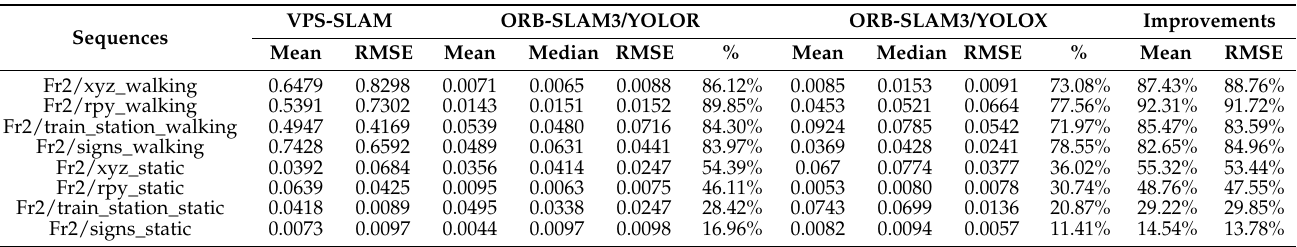
Table 1. YOLOX and YOLOR absolute pose error comparison with VPS-SLAM and